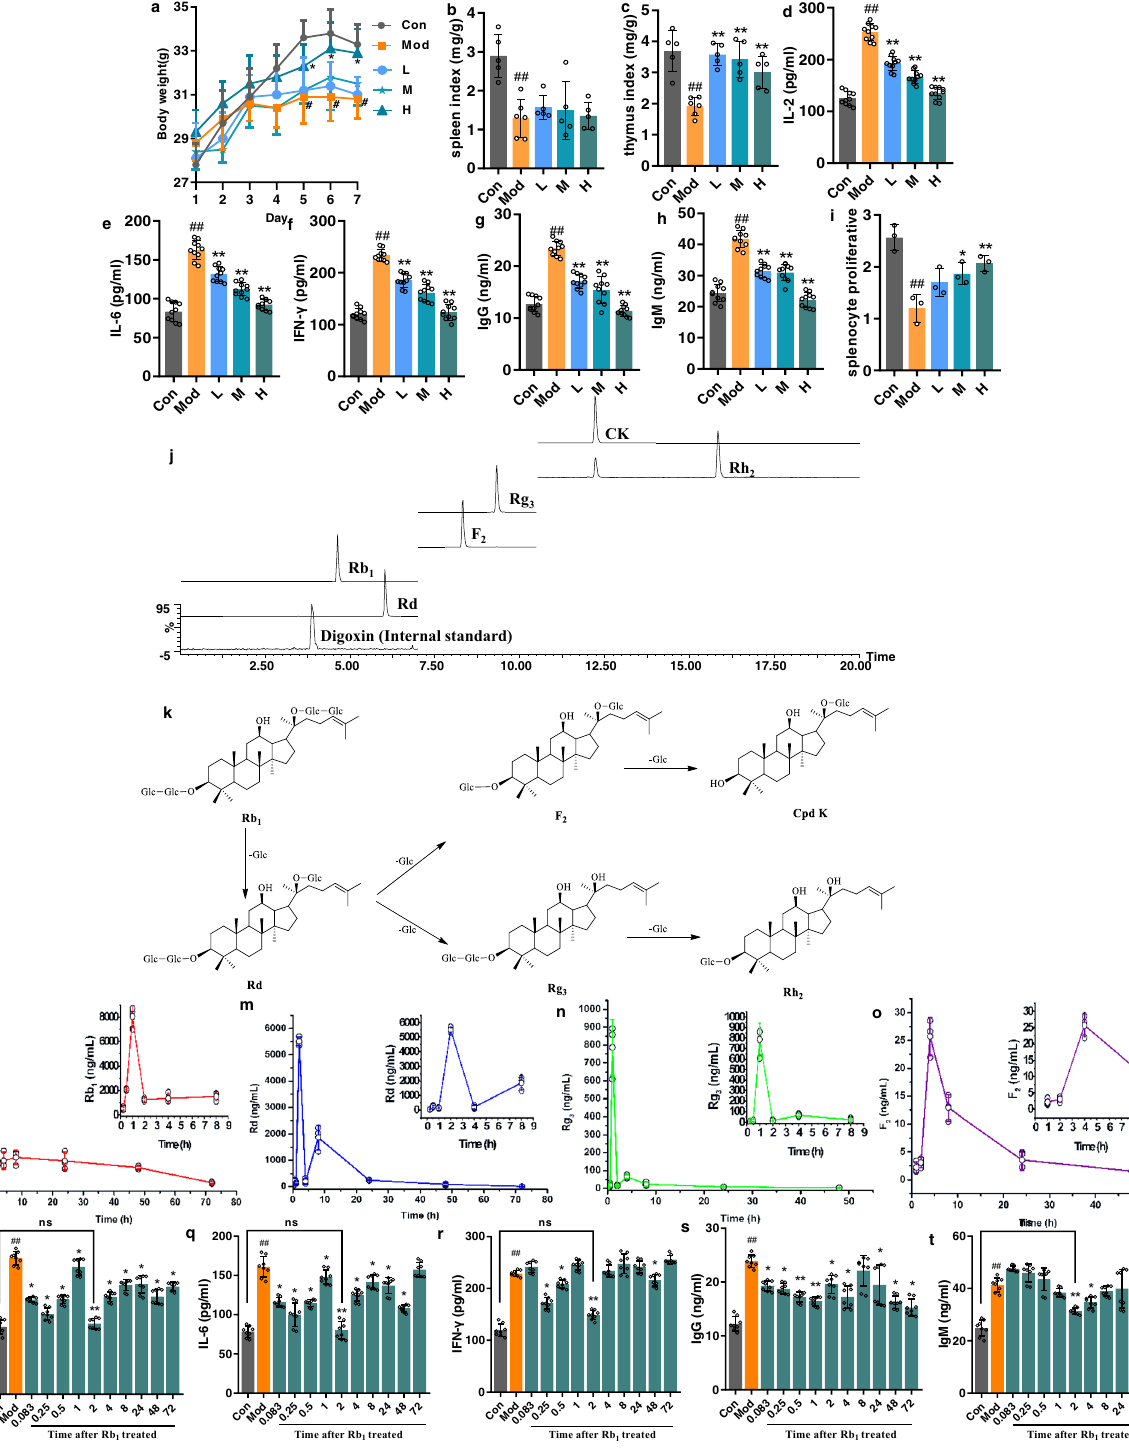
Fig. 1 Pharmacochemical, pharmacokinetic and pharmacodynamic analyses determined the analogues ’ combination as ginsenoside Rb 1 (1247.32 ng/mL, 1.12 µ M), Rd (5510.30 ng/mL, 5.82 µ M), Rg 3 (16.25 ng/mL, 20.72 nM) and F 2 (3.07 ng/mL, 3.91 nM). a Body weight ( n = 10), b spleen index ( n = 5), c thymus index ( n = 5), d IL-2 ( n = 10), e IL-6 ( n = 10), f IFN- γ ( n = 10), g IgG ( n = 10), h IgM ( n = 10) and i splenocyte proliferative ( n = 3). j